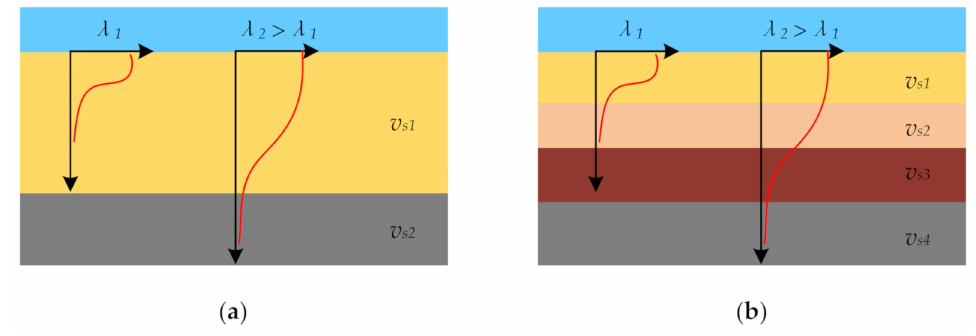
Figure 5. Fundamental mode Scholte wave penetration depth in the ocean bottom. ( a ) The model of large layer thickness; ( b ) the model of smaller layer thickness. In the figure represents the wavelength of Scholte waves (The subscript 1 represents the high frequency and 2 repre-sents the low frequency), and represents the s-wave velocity of the ith